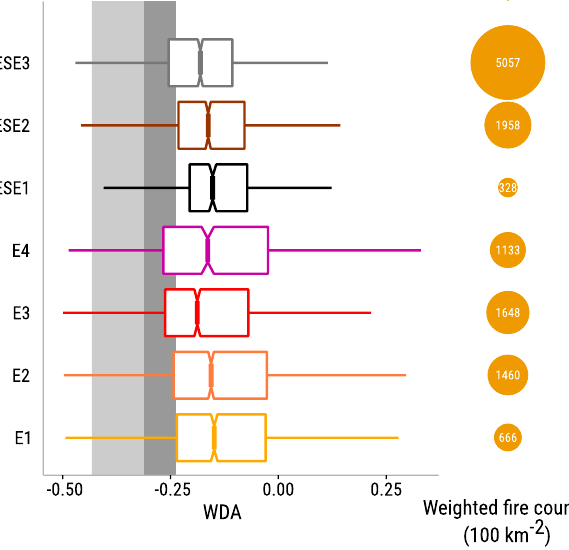
Figure 9. Wavelength dependence of å abs (WDA) for different tra- jectories in the dry season presented as box and whisker plots (left). The light and dark gray shaded areas correspond to the pure BC and internally mixed BC regimes, respectively. Notches correspond to 1.58 IQR n − 1 / 2 . If notch ranges do not overlap, the medians are sta- tistically different (95% confidence). The trajectory weighted fire counts for each BT cluster are shown as circles on the right side. The data presented here correspond to 1h